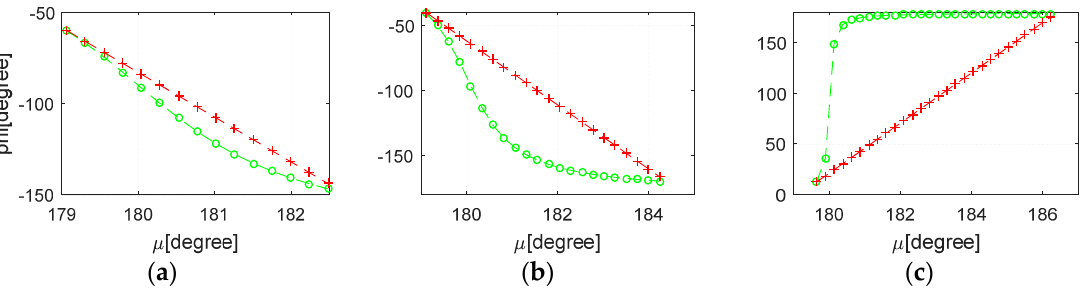
Figure 2. The yaw angle of G21 (IIR) during noon maneuver for different sun angles: ( a ) beta = 1.63°; ( b ) beta = 0.77°; and ( c ) beta = − 0.08°. The nominal yaw angle is shown in green, while the modeled ( b ) beta = 0.77 ◦ ; and ( c ) beta = − 0.08 ◦ . The nominal yaw angle is shown in green, while the modeled one is in red. one is in red. Table 5. The maximum differences and duration for different sun angles (G21). Table 5. The maximum differences and duration for different sun angles